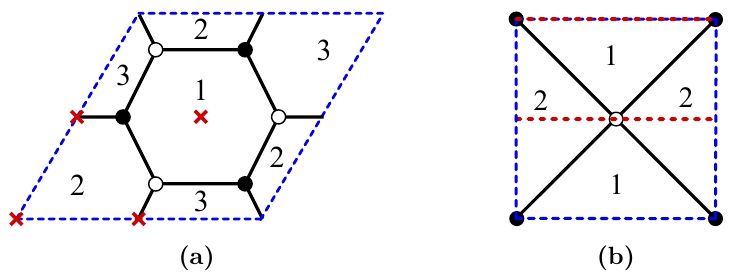
Figure 5. (a) Orientifold of C 3 / Z 3 with fixed points. (b) Orientifold of the conifold with fixed lines. Note that we have changed the unit cell with respect to figure 1b, in order to get one with a Z 2